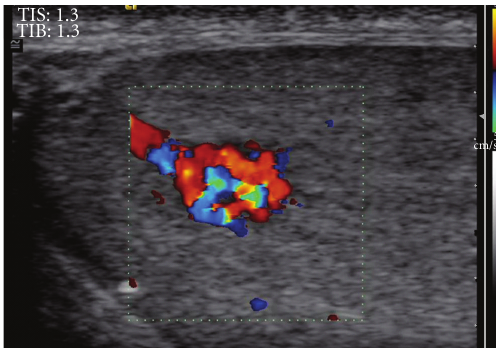
Figure 2: Color Doppler ultrasound demonstrates prominent vessels that entirely involve the